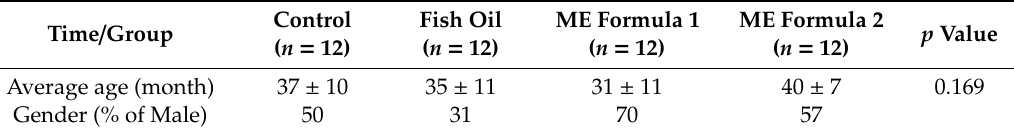
Table 2. Participant